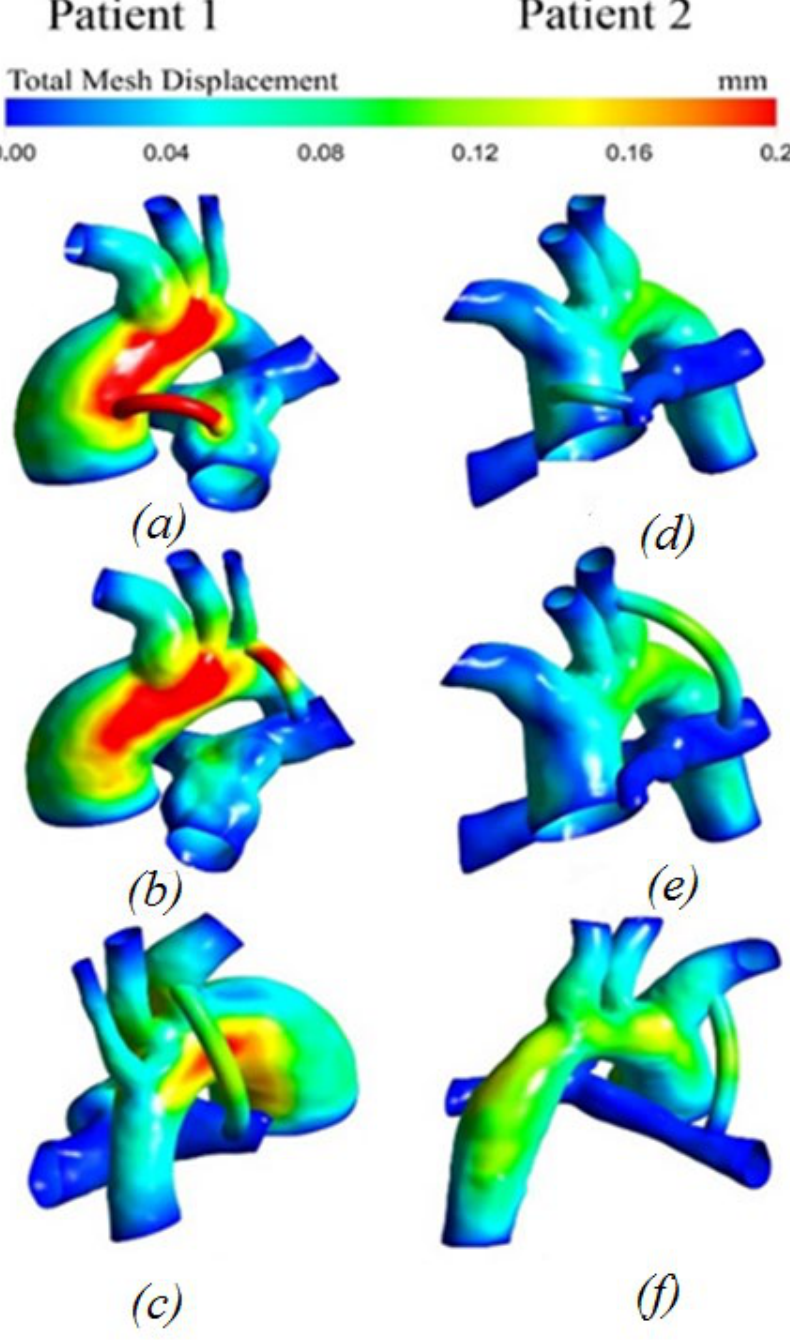
Figure 10. Distribution of displacements with anisotropic properties of the aorta and hyperelastic properties of the shunt: ( a , d ) central shunt; ( b , e ) right shunt; ( c , f ) left shunt.